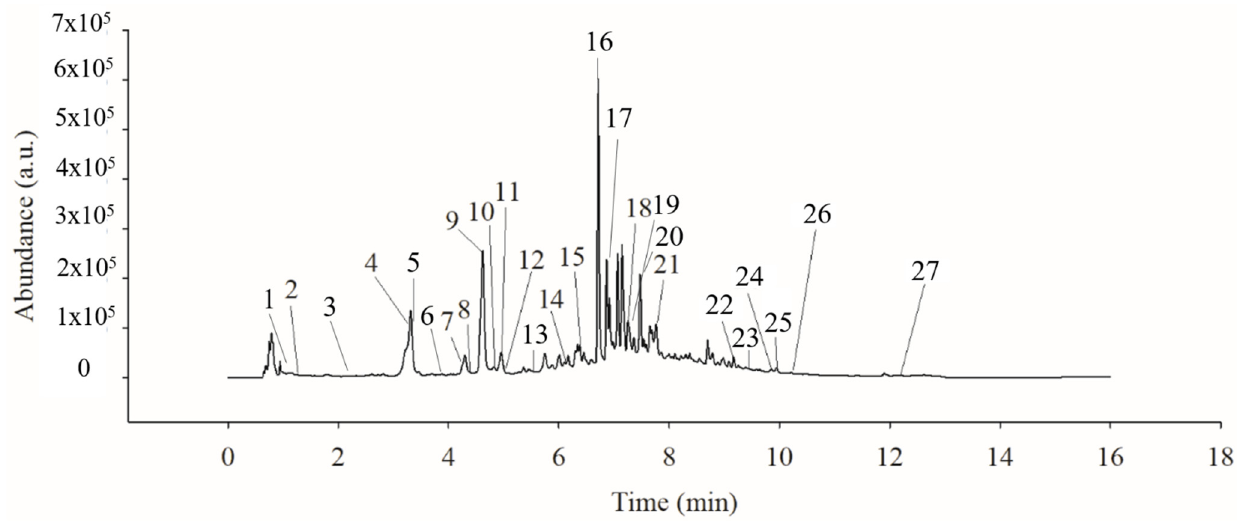
Figure 2. UPLC-PDA chromatogram of Quince fruit ( Cydonia oblonga Mill.) recorded at 280 nm. Peak numbers correspond to the compounds listed in Table 1.